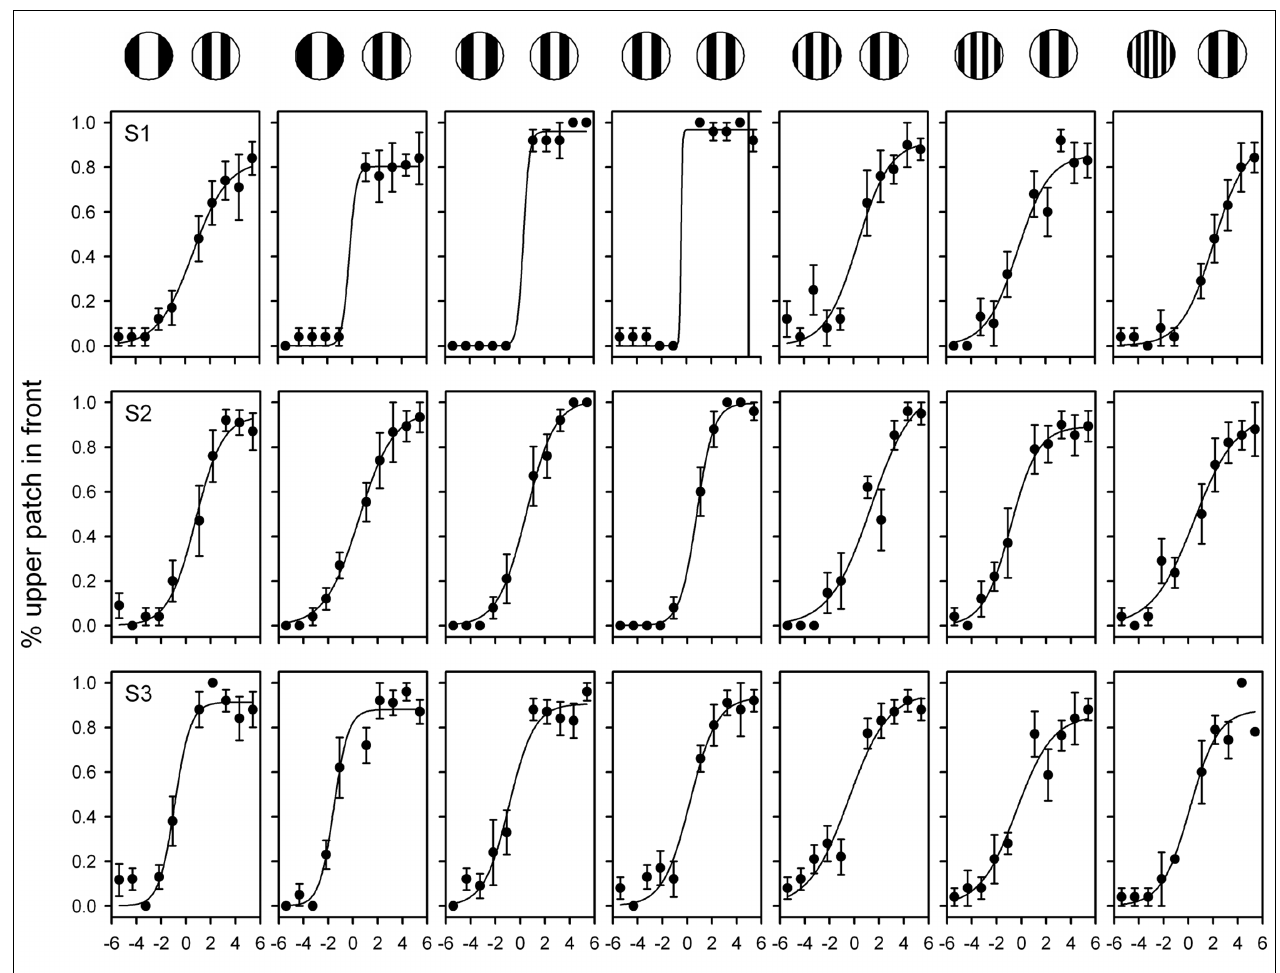
FIGURE 2 | Stereoacuity functions for grating stimuli patches with different spatial frequencies in the two eyes. The combination of spatial frequencies used from (left to right) were: 1.5:3.0, 1.9:3.0, 2.4:3.0; 3.0:3.0; the x axis represents an uncrossed disparity. Bars represent